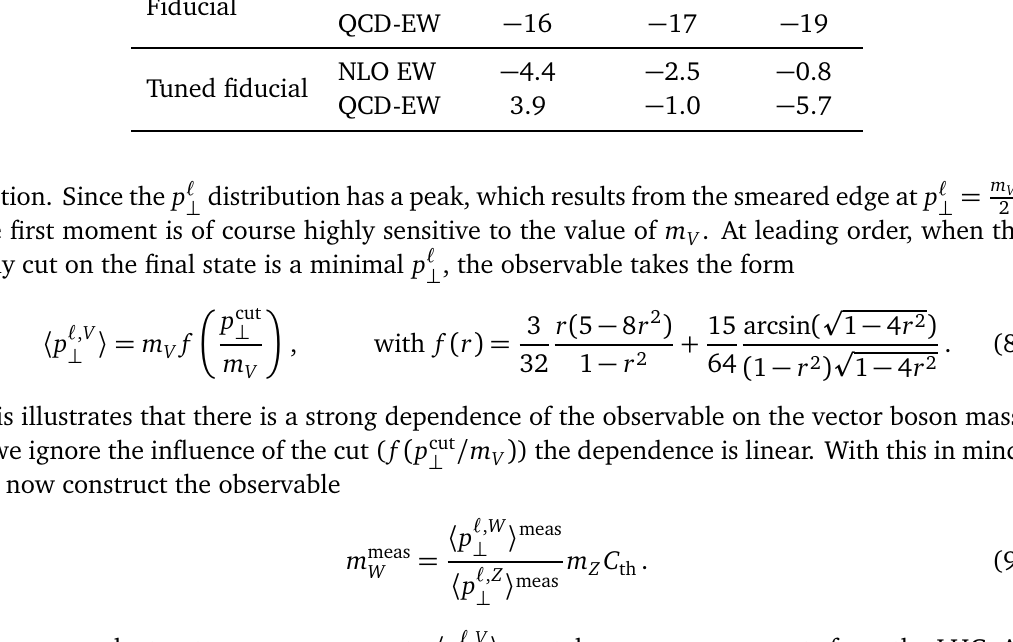
Table 1: Estimates for the shifts of m due to the NLO electroweak and the mixed W QCD-electroweak corrections for different values of the factorisation and renormali- = µ sation scales µ = µ . For details on the three sets of fiducial cuts (“inclusive”, R F “fiducial” and “tunded fiducial”) see the main text. δ m [ MeV ] µ = m / 4 µ = m / 2 µ = m W V V V NLO EW − 0.1 0.3 0.2 Inclusive QCD-EW − 5.1 − 7.5 NLO EW Fiducial